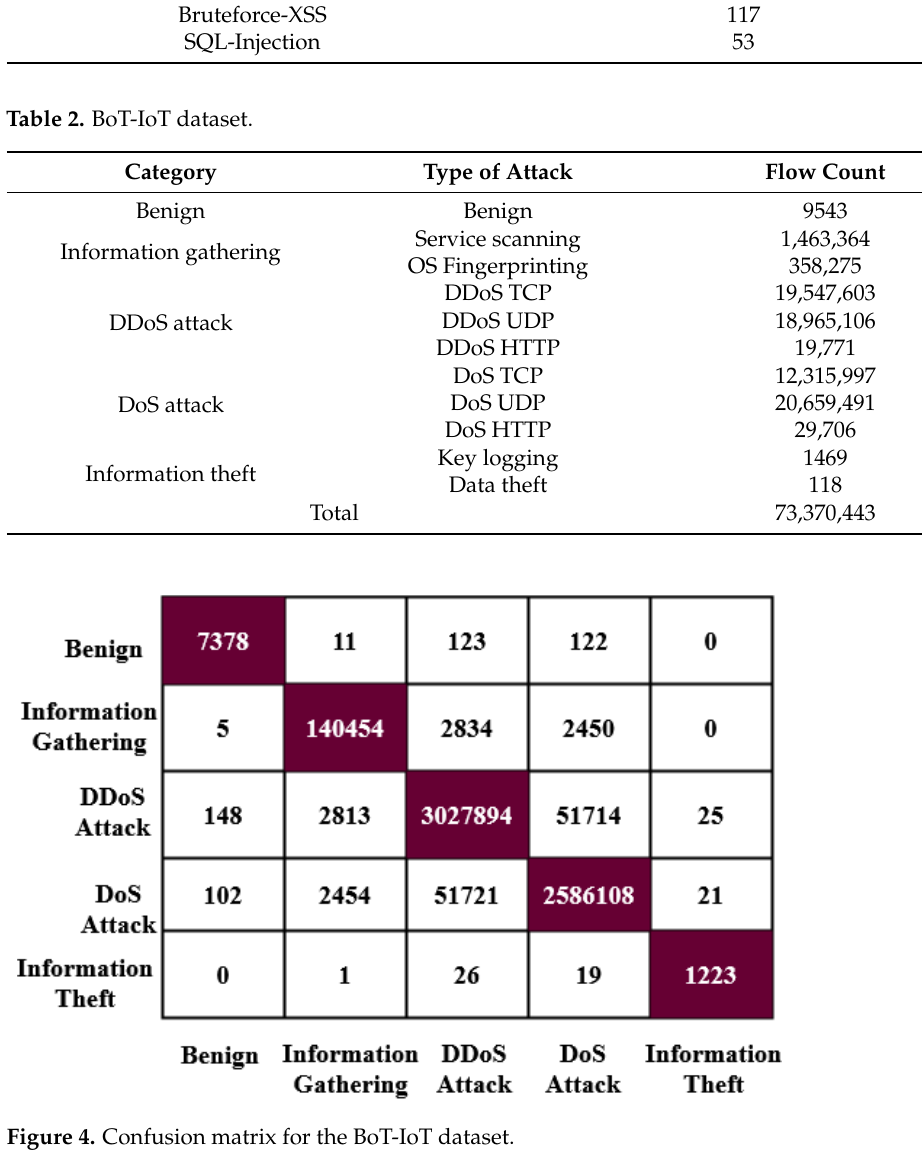
Figure 5. ROC analysis for the BoT-IoT dataset. 00.2 0.4 0.6